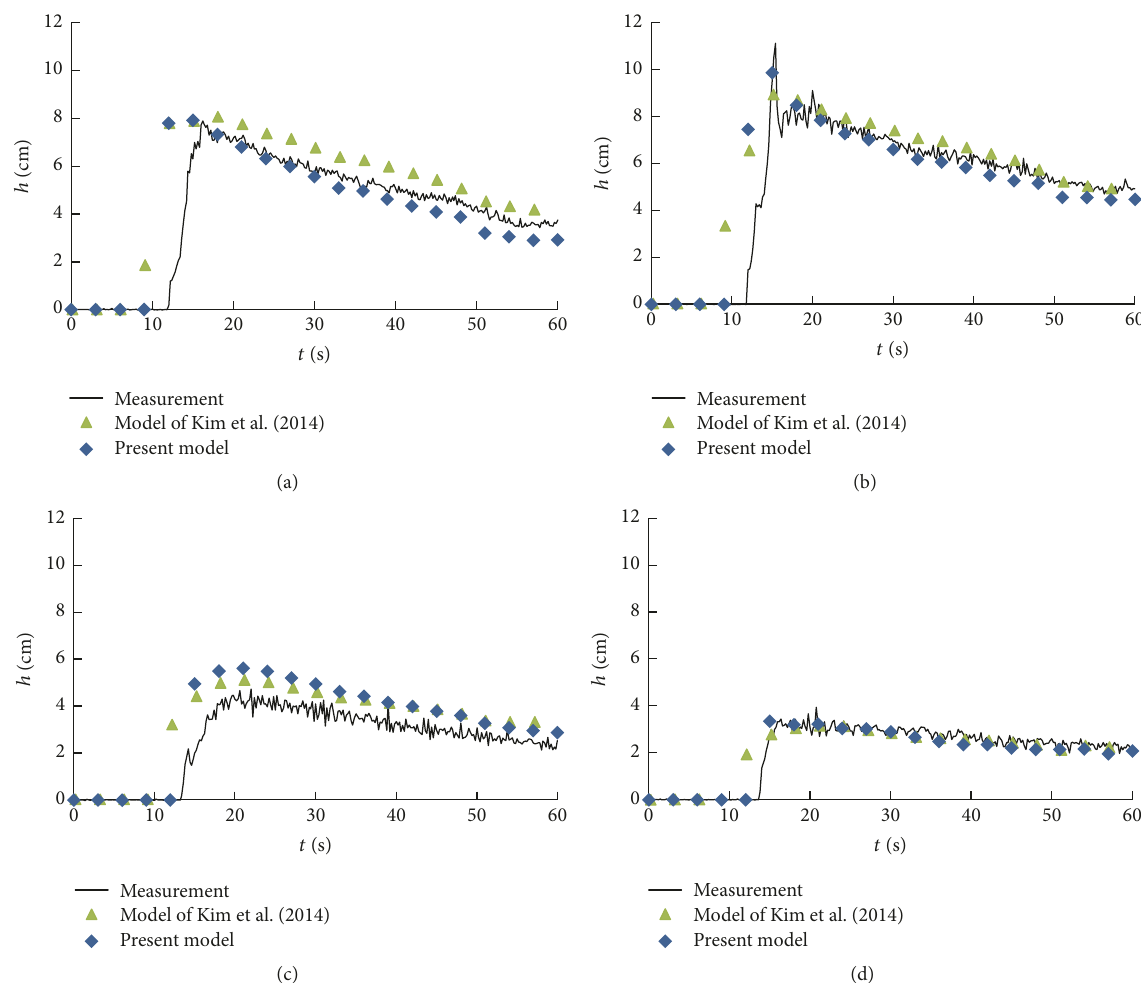
Figure 5: Comparison of numerical results with physical experiment: (a) P3; (b) P4; (c) P9; (d) P10.